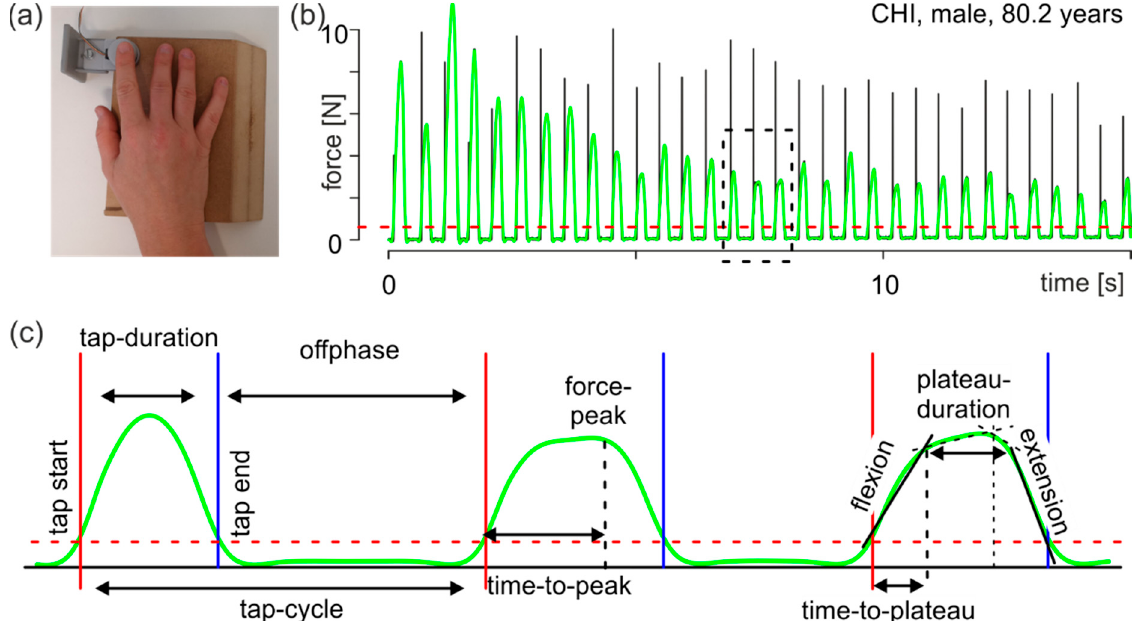
Figure 1. Methods. ( a ) Experimental setup. ( b ) Characteristic force curve of tapping. Black line: original recorded force curve; green line: low-pass filtered force curve; red dashed line: force threshold (see text); the dashed rectangle indicates the interval shown in c. ( c ) Example interval with three taps showing all time and force parameters (see text). Green line: filtered force curve; red vertical solid line: start point of an individual tap; blue vertical solid line: end point of an individual tap; red dashed line: force threshold; black vertical dashed line in the middle tap: time point of the force peak; black vertical dashed lines in the right tap: break points of the two ‐ linear spline models (see text).